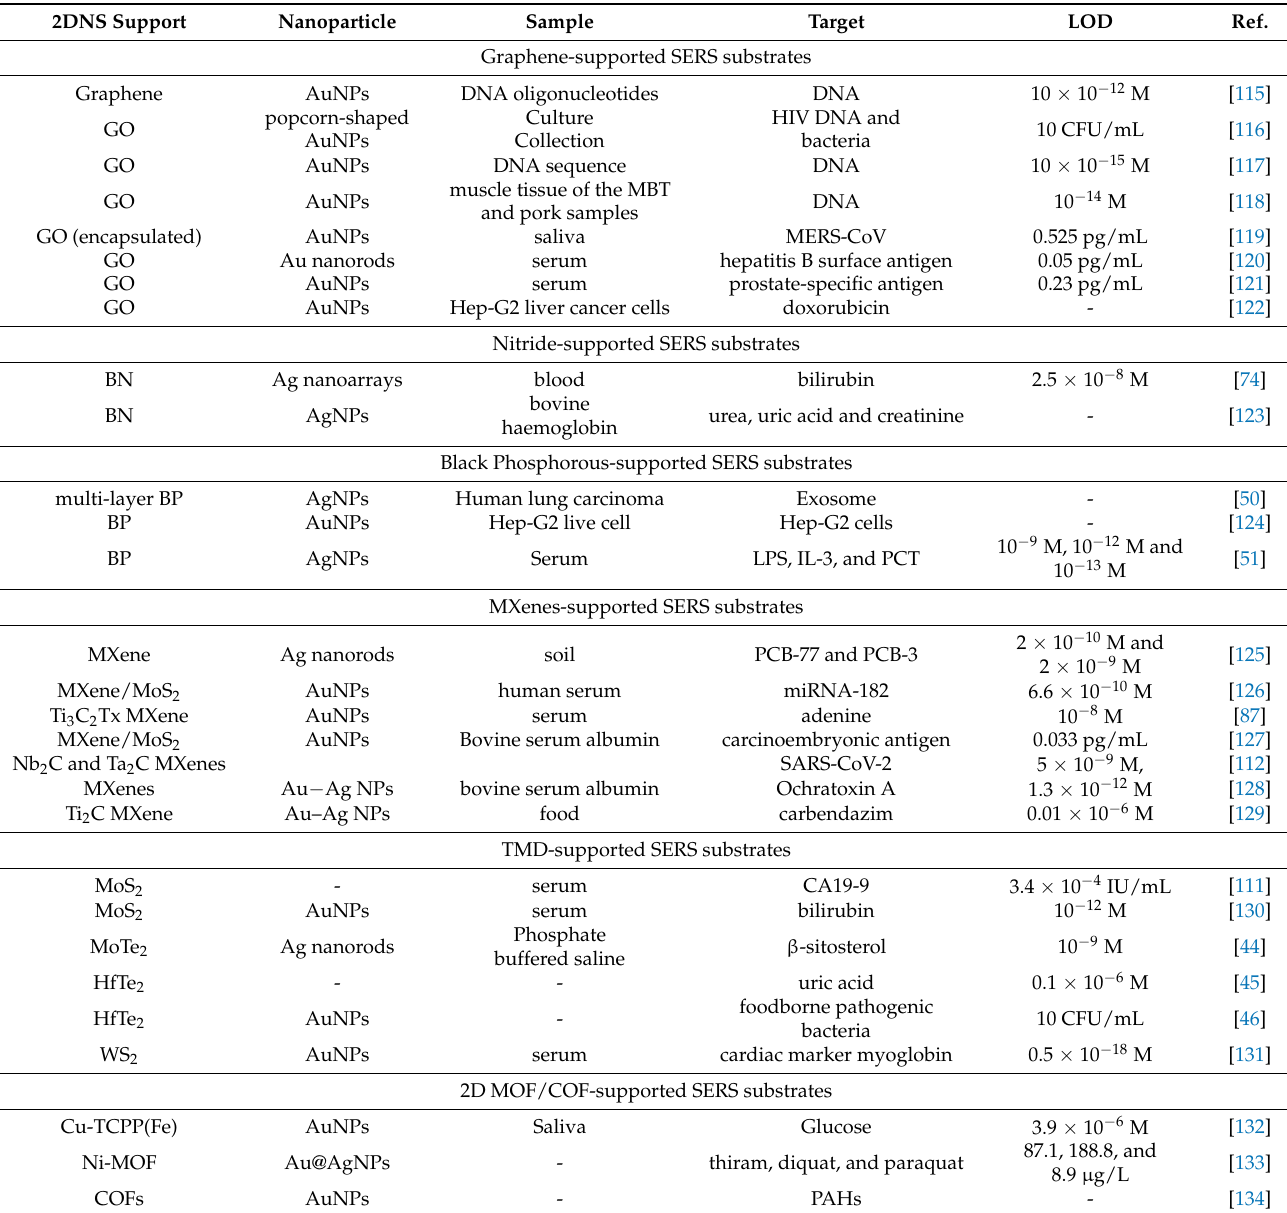
Table 2. Comparison of various 2DNS-supported plasmonic nanoparticle SERS substrate used in the detection of